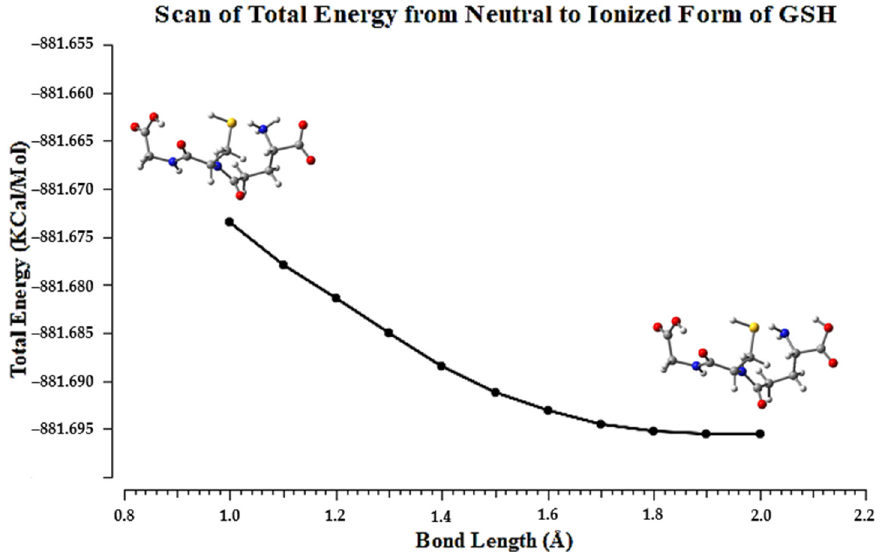
Figure 4. Plot showing the total energy derived from a relaxed potential energy surface sweep for the proton transition to the neutral and ionized forms of GSH, varying the distance N 1 ⋯ H by 1.0 Å in 0.1 Å increments.